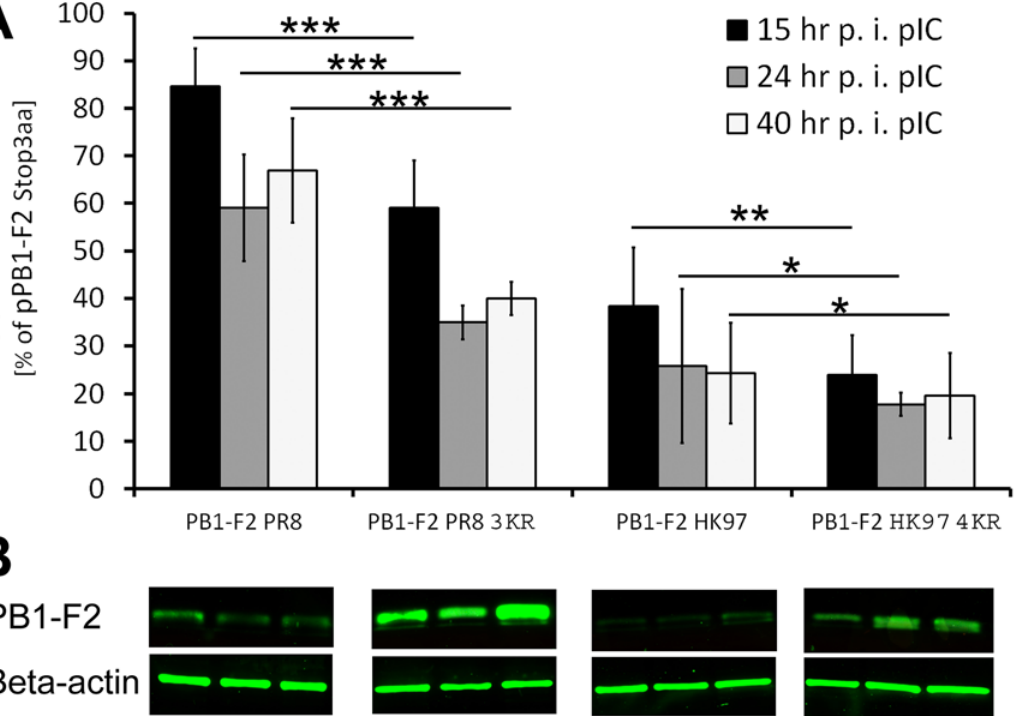
Fig 8. Effect of PB1-F2 stabilization on the induction of the human IFN- β promoter. (A) A 293T cells were co-transfected with the human IFN- β promoter reporter plasmid pGLhIFNBpr, pRLTK (transfection efficiency normalization) and the respective PB1-F2 expressing plasmids (pPB1-F2 PR8/pPB1-F2 PR8 3KR/pPB1-F2 HK97/pPB1-F2 HK97 4KR/pPB1-F2 Stop3aa). At 24 hr p.t., the IFN- β promoter was further induced through the addition of pIC. At 15, 24 and 40 hr p.t., the supernatant was removed, and the cells were gently washed, directly lysed using passive lysis buffer (Promega) and the luciferase activity was quantified using the Dual Luciferase Reporter Assay System kit (Promega) on a BIOTEK Synergy HT luminometer. The samples were measured in triplicate and normalized to renilla luciferase activity (transfection efficiency) and firefly luciferase activity (human IFN- β promoter induction) determined for pPB1-F2 Stop3aa co-transfected samples. The data represent 3 independent experiments. The bars indicate the average value of the independent experiments, and the error bars indicate the intra-experiment SD values. The asterisk indicates a significant difference between the groups compared ( * P < 0 . 05 ; ** P < 0 . 01 ; *** P < 0 . 001 ). (B) PB1-F2 protein and Beta-actin was detected through western blotting to compare the induction of IFN- β promoter with the relative amount of the PB1-F2 in the same